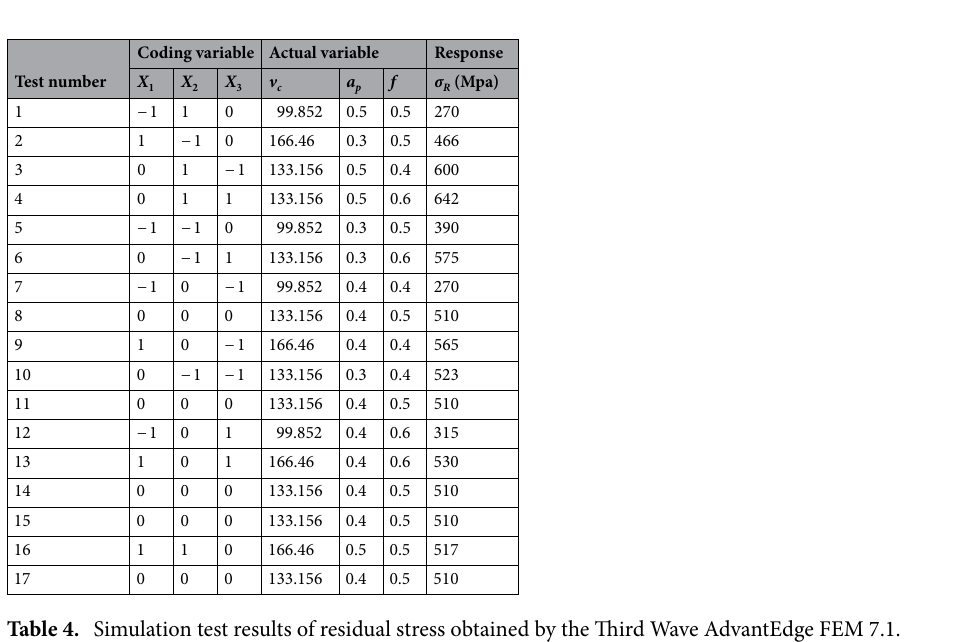
Table 4. Simulation test results of residual stress obtained by the Third Wave AdvantEdge FEM 7.1.